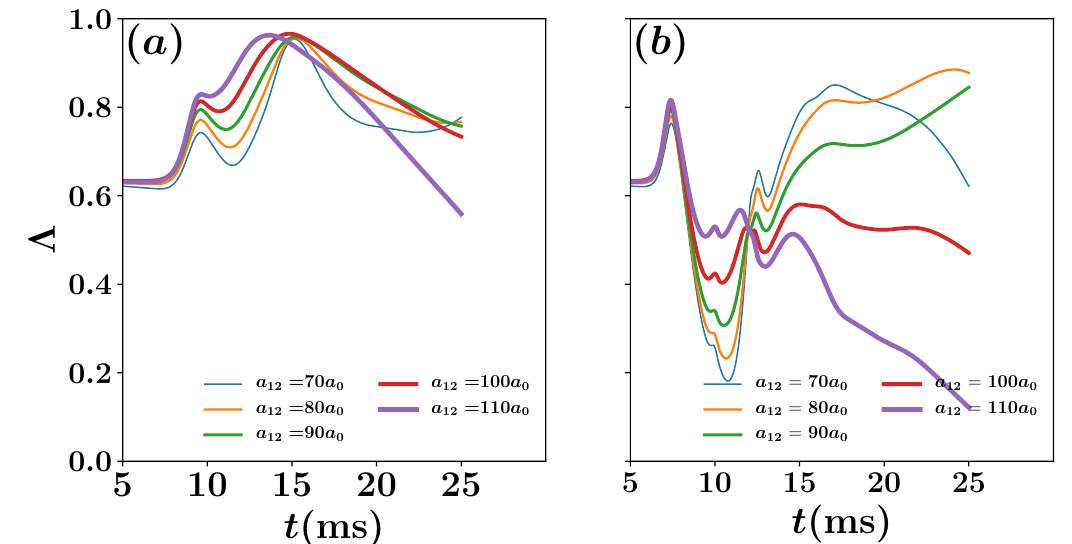
Figure 7. (Color online) Shows the time evolution of the overlap integral Λ for a fixed Rabi frequency, with ( a ) V max = 1 and ( b ) V max = 10, and different interspecies scattering lengths a 12 [see legends]. The dynamics is initiated by employing LG(pump)-G(stokes) pulse sequence. The binary BECs are confined in harmonic trapping potential with frequency ω = 2 π × 30.832 Hz. The total number of atoms in the system is N = 10 4 and the intraspecies scattering lengths are given by a 11 = 100.04 a 0 and a 22 = 95.44 a 0